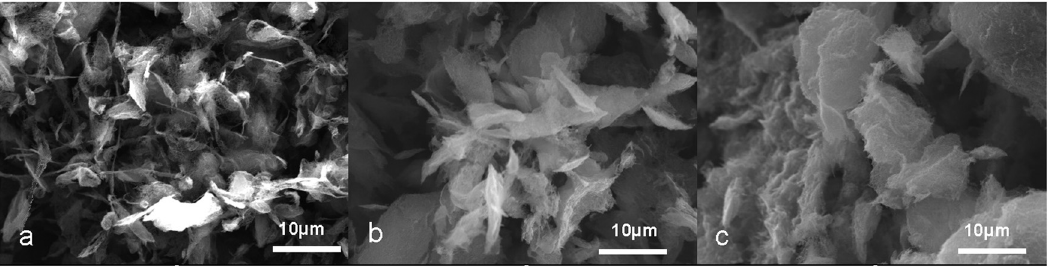
Table 1: EDS results for CNTs with fl uorescent dyes Element Mass%